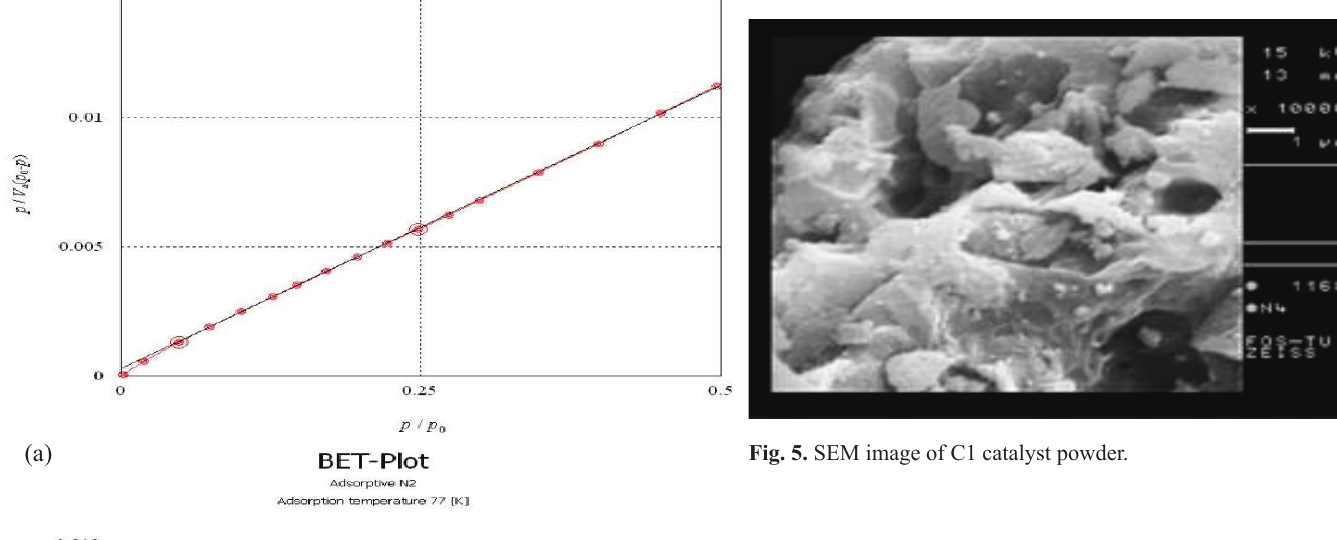
Fig. 5. SEM image of C1 catalyst powder.